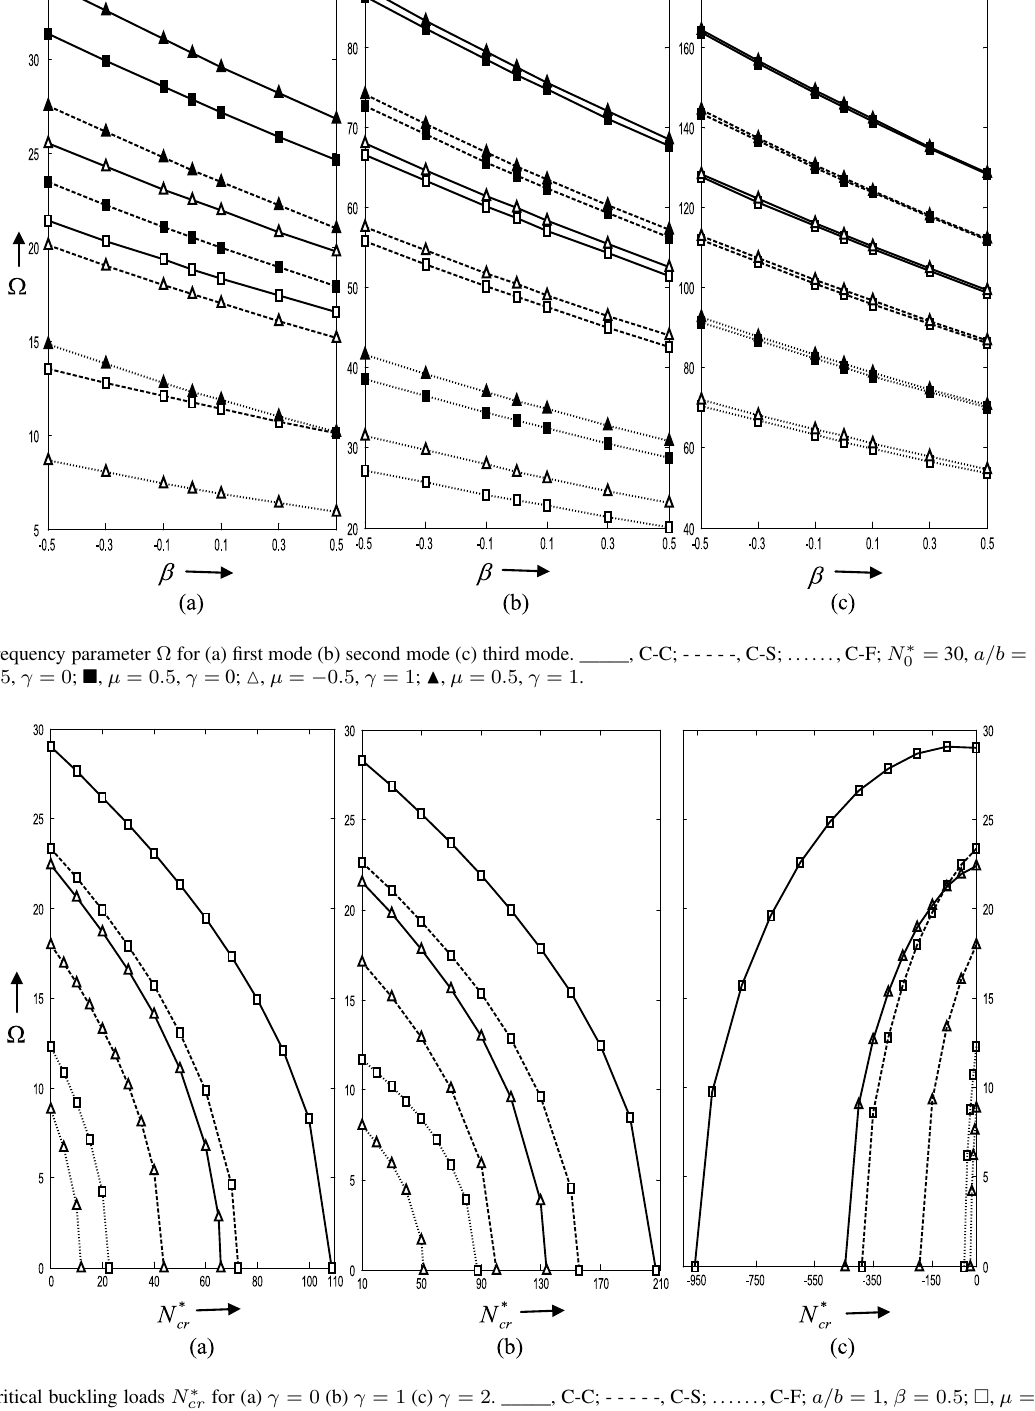
Fig. 9. Critical buckling loads N ∗ cr for (a) γ = 0 (b) γ = 1 (c) γ = 2 . _____, C-C; - - - - -, C-S; ......, C-F; a/b = 1 , β = 0 . 5 ; (cid:3) , μ = 0 . 5 ; (cid:4) , μ = − 0 . 5